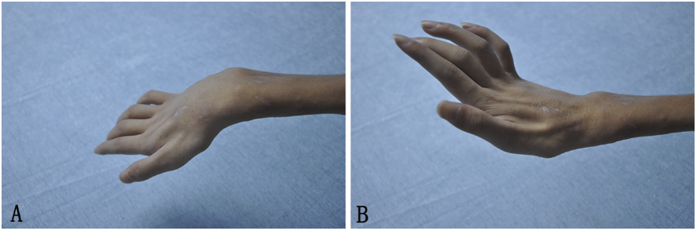
Patient recover satisfactory wrist and fingers extension after gracilis transfer.(A) Natural state (B). Active wrist and fingers extension state.